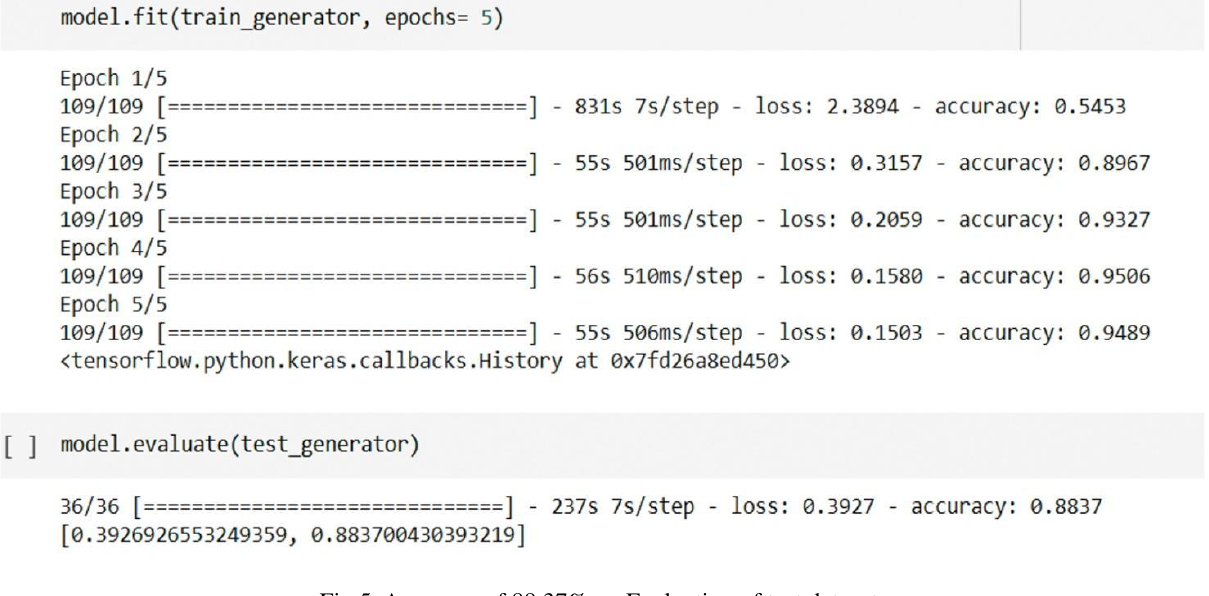
Fig.5. Accuracy of 88.37% on Evaluation of test dataset Fig.6. Class Prediction on a random Diving image from